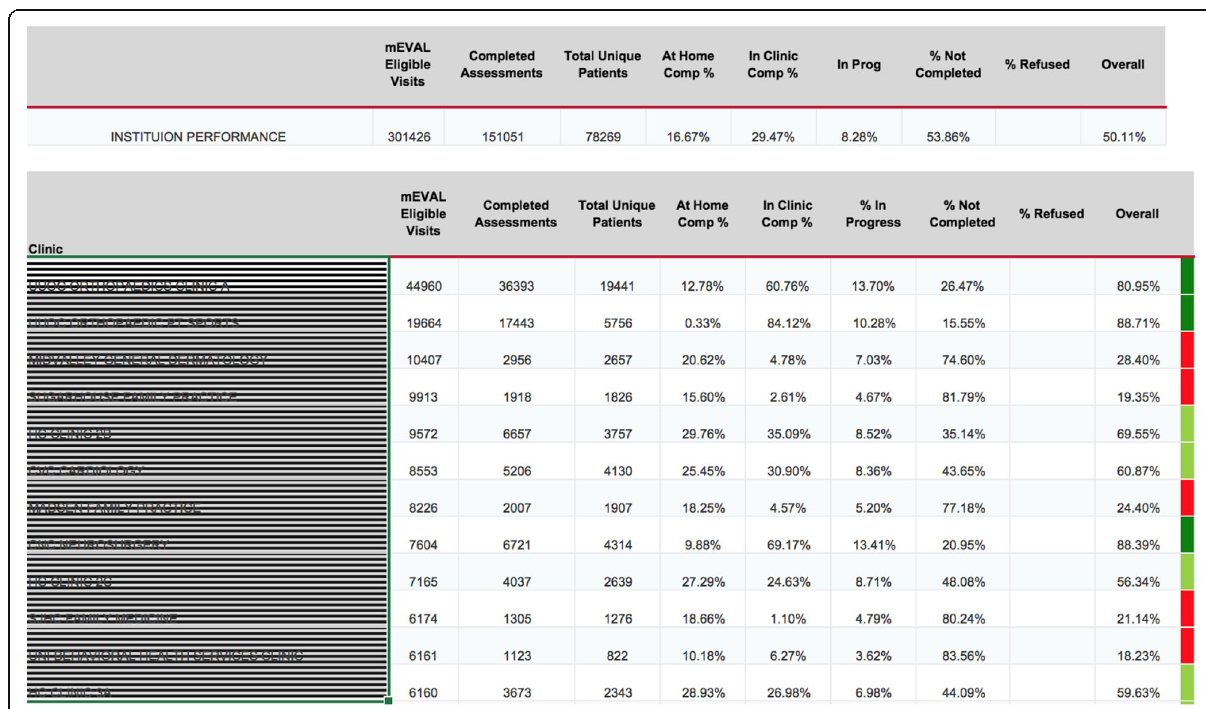
Fig. 3 mEVAL Dashboard used to assess Completion Percentage across clinics and providers. Definitions: In Progress- patient did not completed all questions and no completion time was recorded. Completed- patient answered all question and completion time was recorded. Overall- summation of completed at home and in clinic, plus in progress or refused